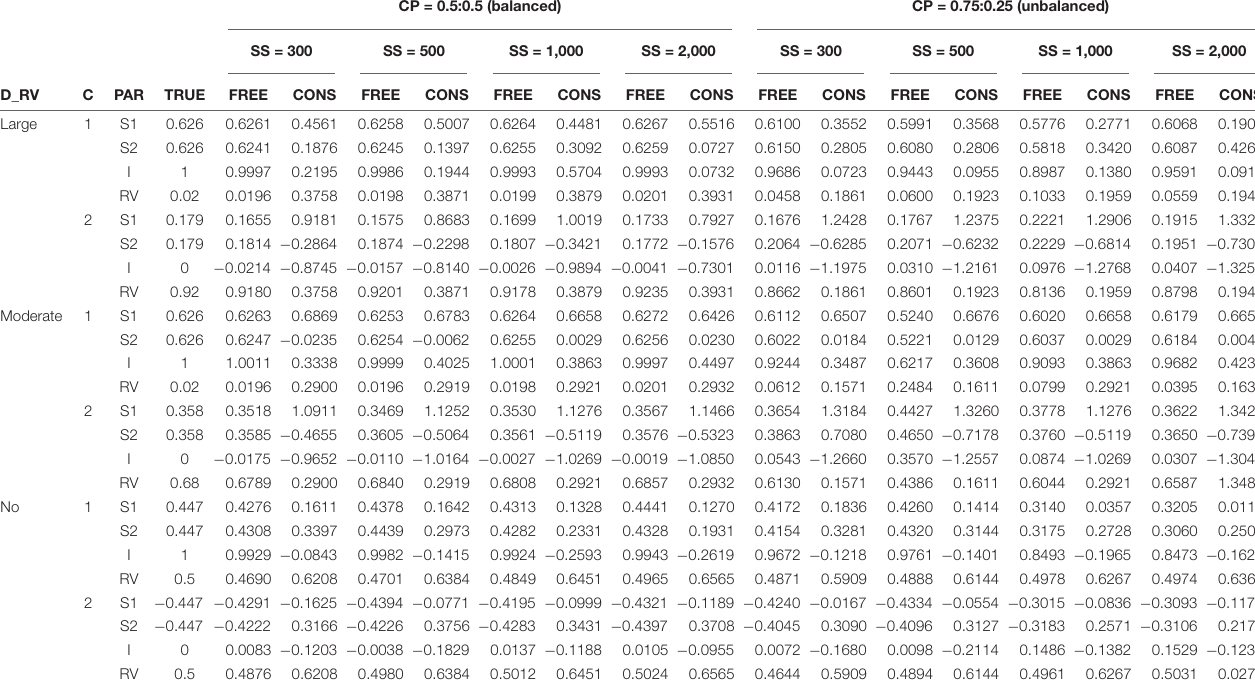
TABLE 6 | Parameter estimates of two-predictor models with intercept difference